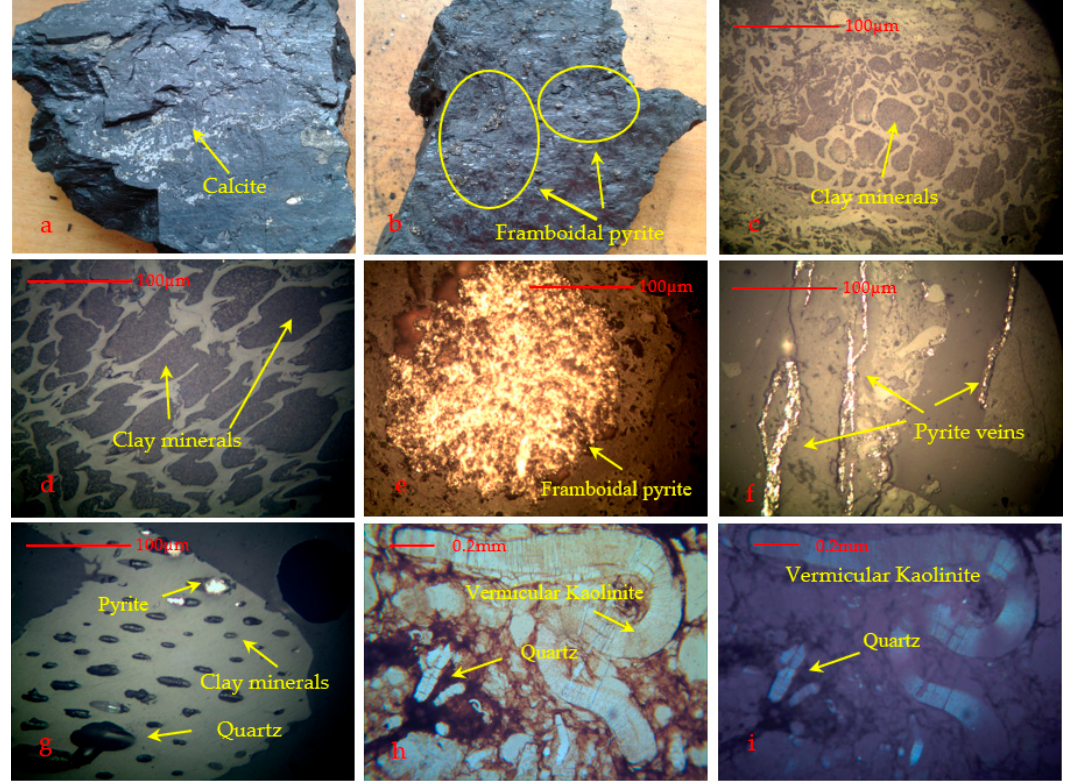
Figure 9. The coal petrography characteristics for No. 4 and No. 6 coal: ( a ) thin-film calcite; ( b ) framboidal pyrite in 6-3; ( c ) cell-filling clay minerals in 4-2, reflected light 10 × 50; ( d ) cell-filling clay minerals in 6-3, reflected light 10 × 50; ( e ) framboidal pyrite in 6-3, reflected light 10 × 50; ( f ) vein pyrite in 6-10, reflected light 10 × 50; ( g ) cell-filling pyrite, quartz, and clay minerals in 6-2, reflected light 10 × 50; ( h ) vermicular clay minerals and quartz in 4-6 g, plane-polarized light 10 × 10; and ( i ) vermicular clay minerals and quartz in 4-6 g, crossed-polarized light 10 × 10.